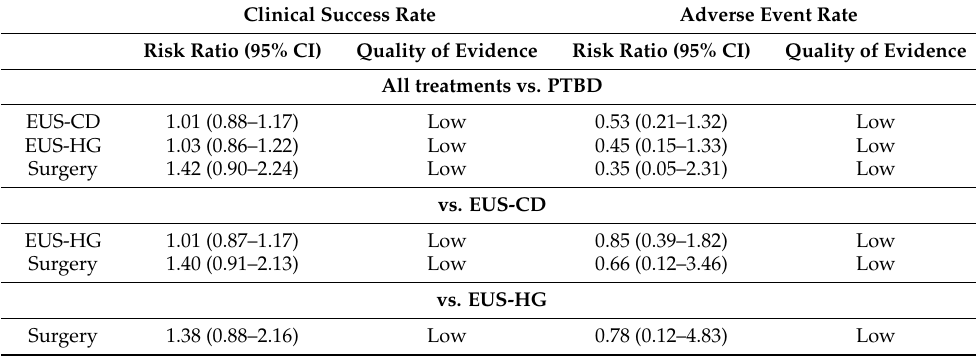
Figure 2. Network of the interventions tested in the included trials. Table 2. Results of the network meta-analysis concerning clinical success rate and adverse event rate.